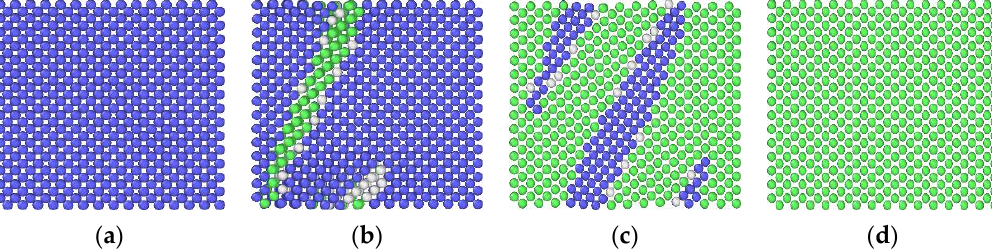
Figure 9. The evolution of the internal crystal structure of the aged Fe-3.5Cu-0V alloy ( a ) 0%-8.2% strain ( b ) 8.3% strain ( c ) 27% strain ( d ) 31.5 – 53% strain, blue part represents BCC structure; green part denotes FCC structure; white part represents other structures.